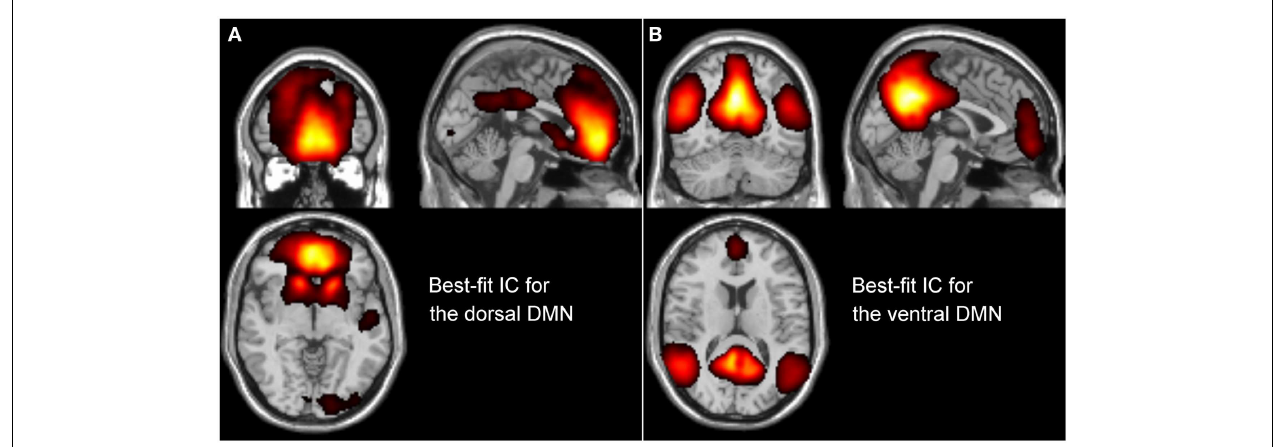
FIGURE 1 | Description of the best-fit independent components (ICs) for the dorsal DMN (A) and ventral DMN (B), resulted from the group ICA.